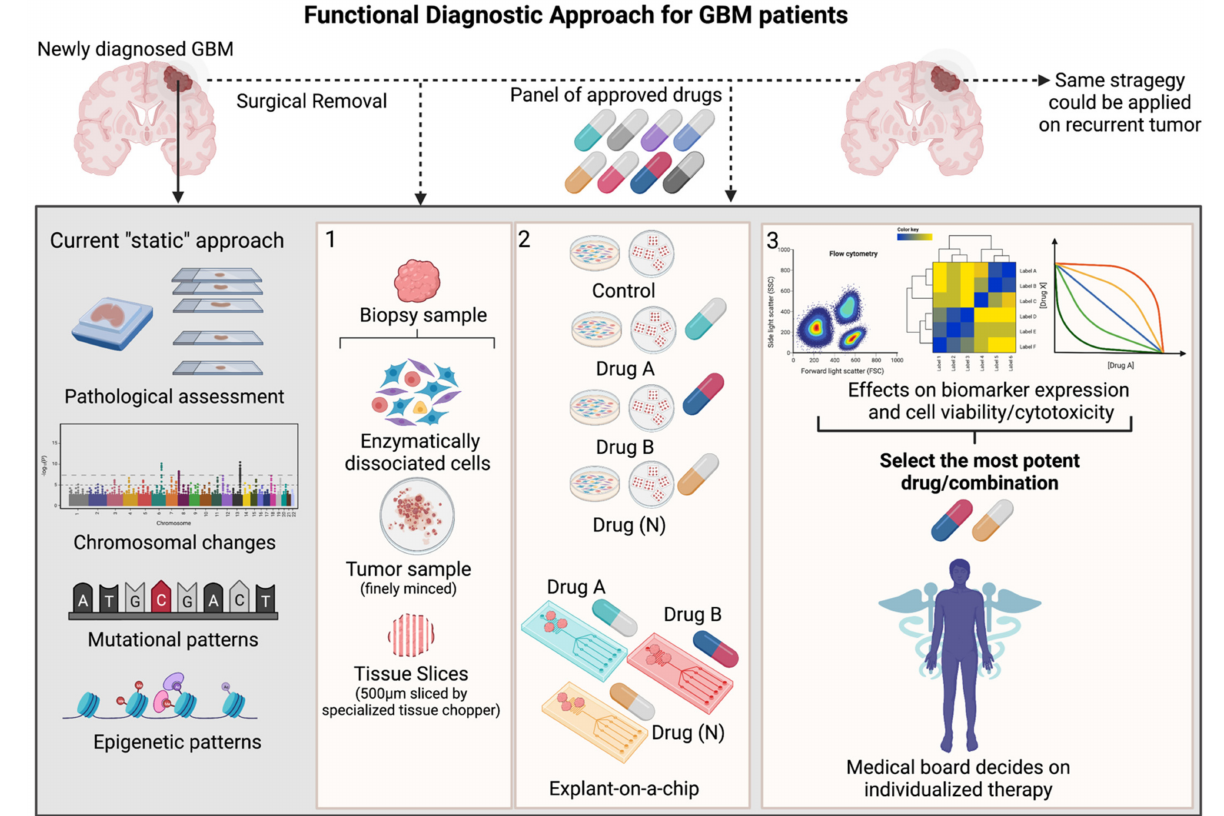
Figure 1. Schematic overview of functional diagnostic approach in GBM (Created with